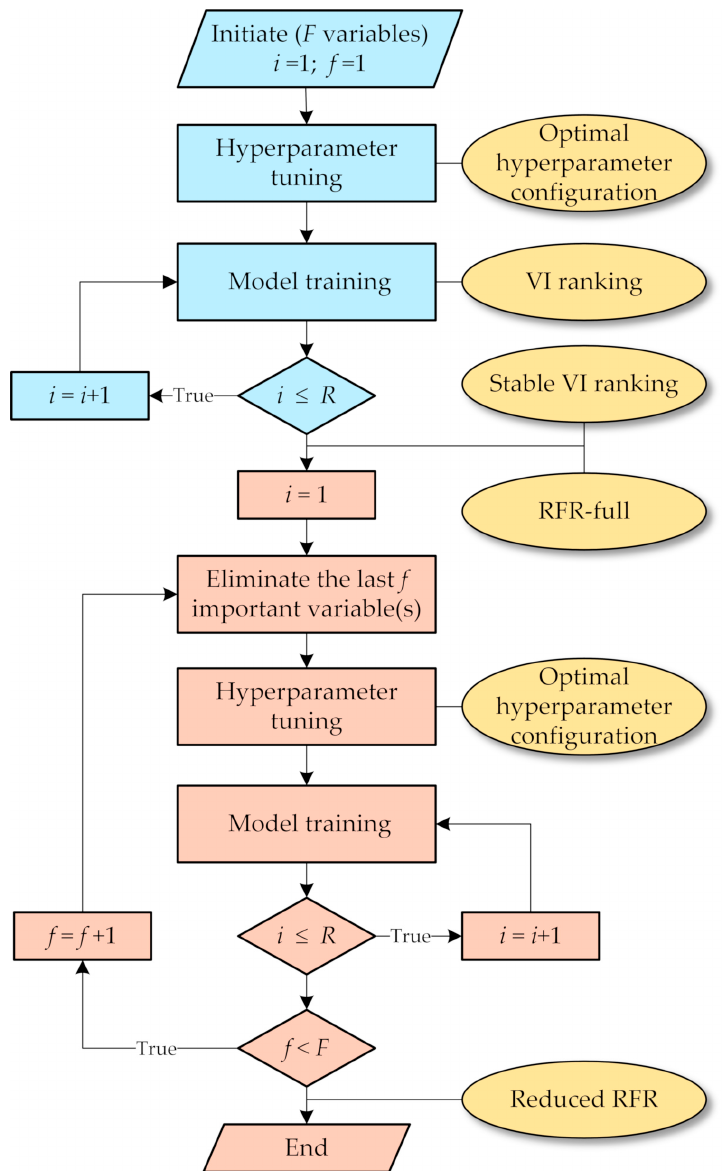
Figure 3. Schematic of the backward variable elimination (BVE) procedure for model selection. The count variable i denotes the round number of model training. It is reset to 1 before entering the reduced RFR selection cycle. The variable f denotes the number of variable(s) discarded. R is the number of runs. The variable importance scores are obtained simultaneously when a RFR-full is trained each time.